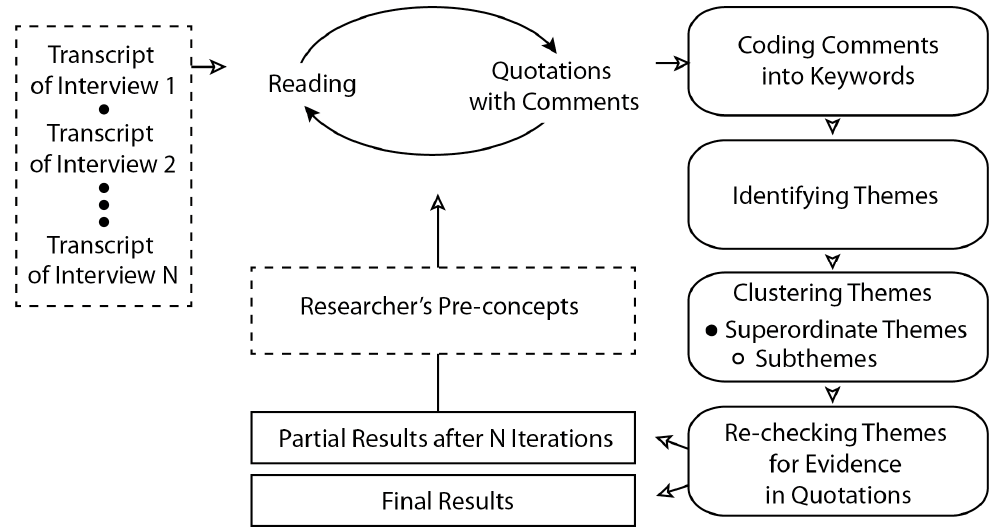
Figure 7. Scheme of the interpretative phenomenological analysis.